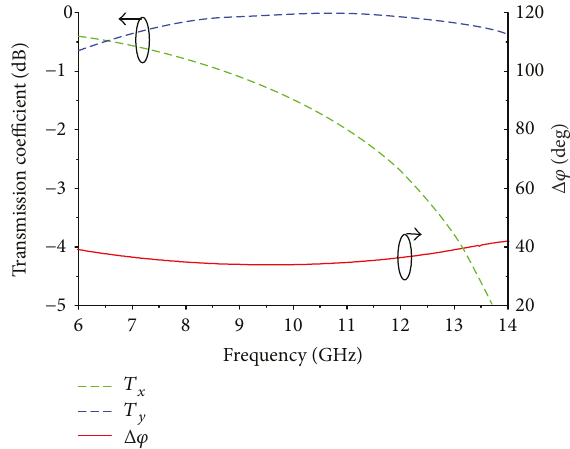
Figure 2: The transmission coe ffi cients and phase di ff erence of the single